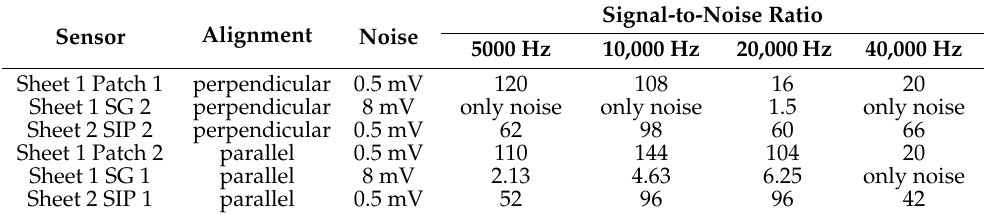
Table 5. Signal-to-noise ratios of the sensors.